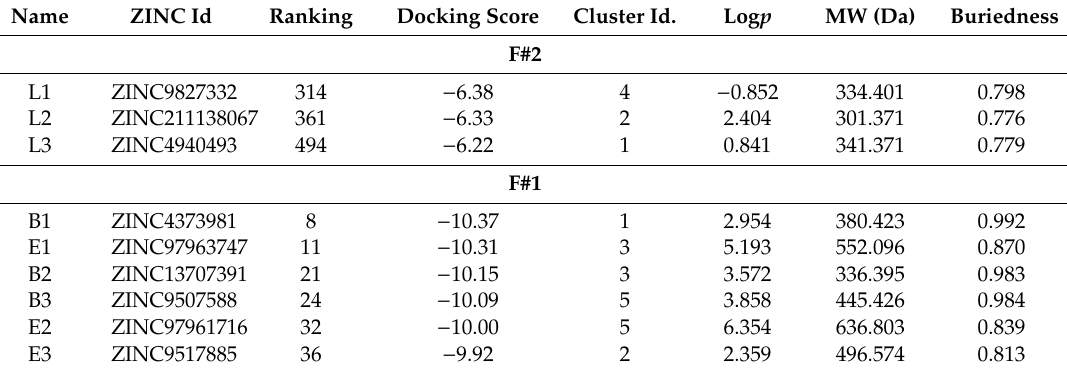
Table 2. Prioritized molecules obtained from the structure-based virtual screening (SBVS) performed on Sites F#1 and F#2. Molar weight and log p values were taken from the ZINC database entries